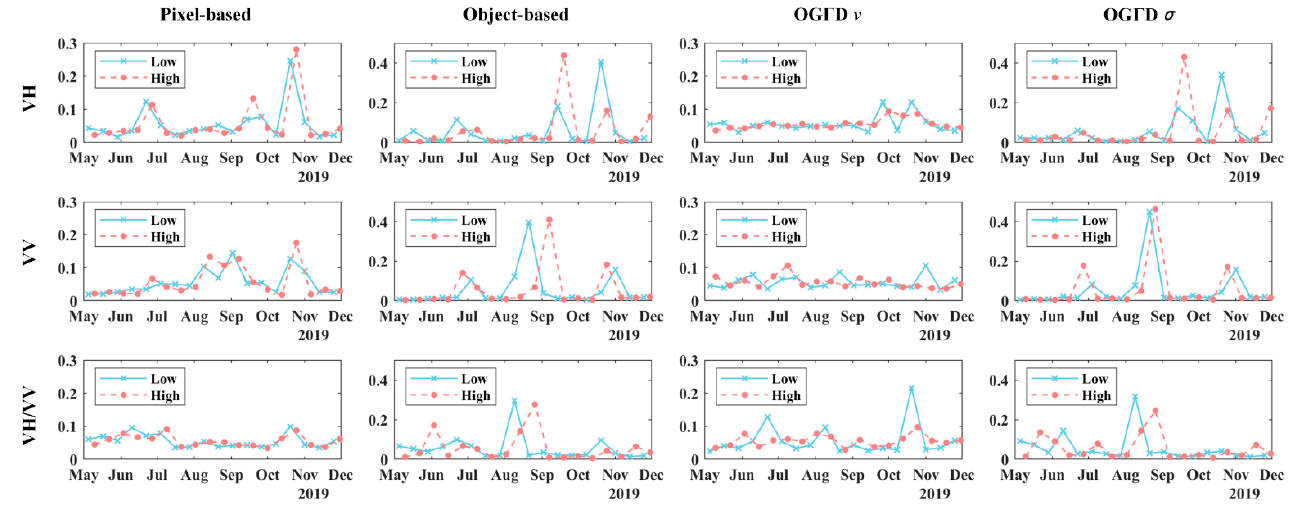
Figure 11. The results of feature evaluation. The solid line represents a low incidence angle, and the dashed line is a high incidence angle. Each row represents a polarization (VH, VV, VH/VV) and each column represents a feature type. The x -axis is the date and the y -axis is the feature importance value.